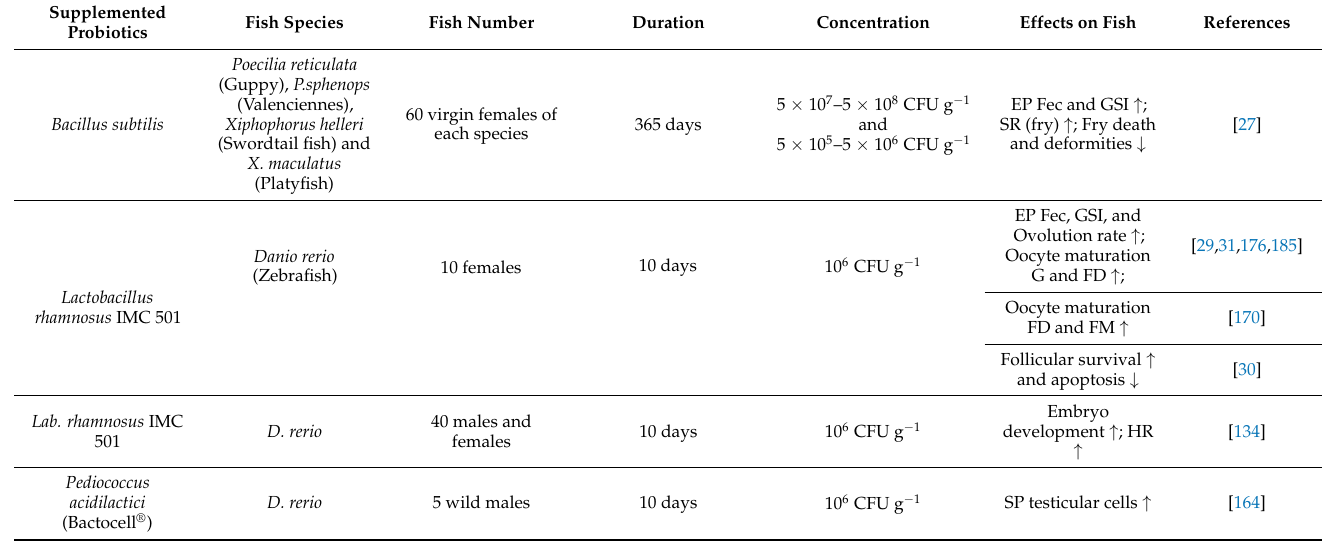
Table 2. Dietary supplemented probiotics effects on ornamental fish reproduction. Symbol: no change ( → ); increase ( ↑ ); decrease ( ↓ ) versus